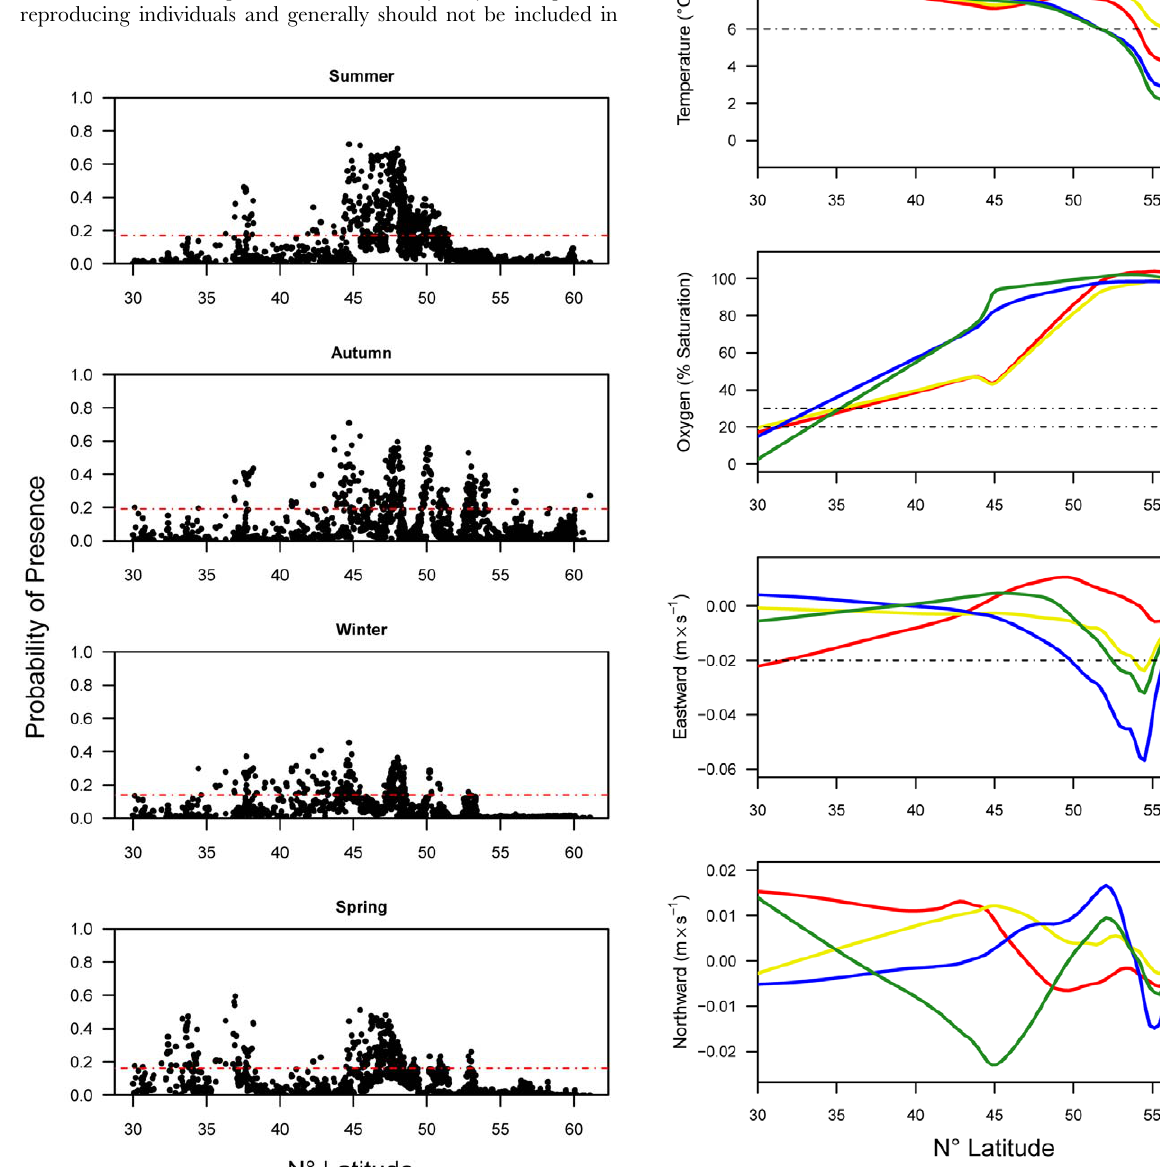
Figure 6. Seasonal model covariate values by latitude. Smoothed (loess) lines generated using model seasonal covariate background values across the green sturgeon range from 30 to 60 u N; red=summer, yellow=autumn, blue=winter, green=spring. The dashed lines represent green sturgeon response threshold values that are described in the text (see Figure 2).